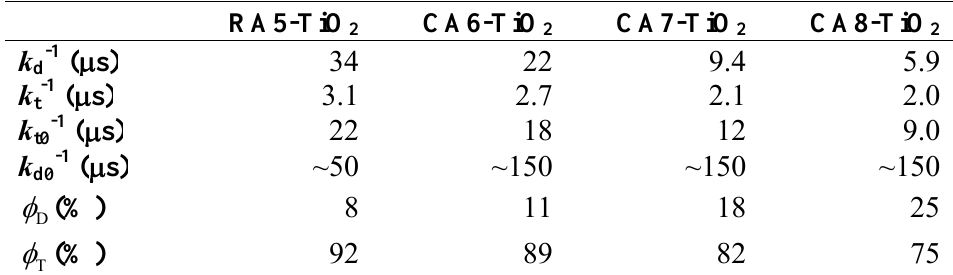
•+ − T complex to the D 0 1 •+ and T lifetimes ( k d0-1 and k t0-1 ). The 0 1